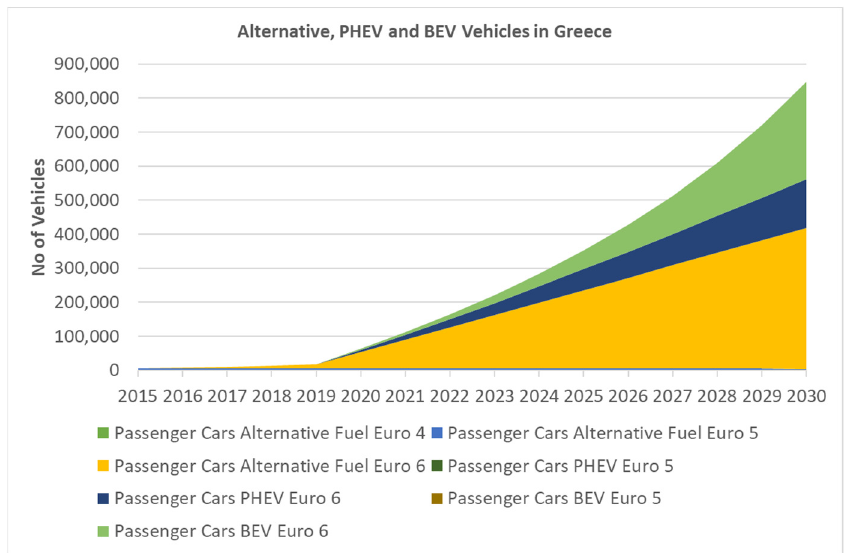
Figure 8. Time-evolution of the fleet size of alternative and electric passenger vehicles in Greece, up to 2030.